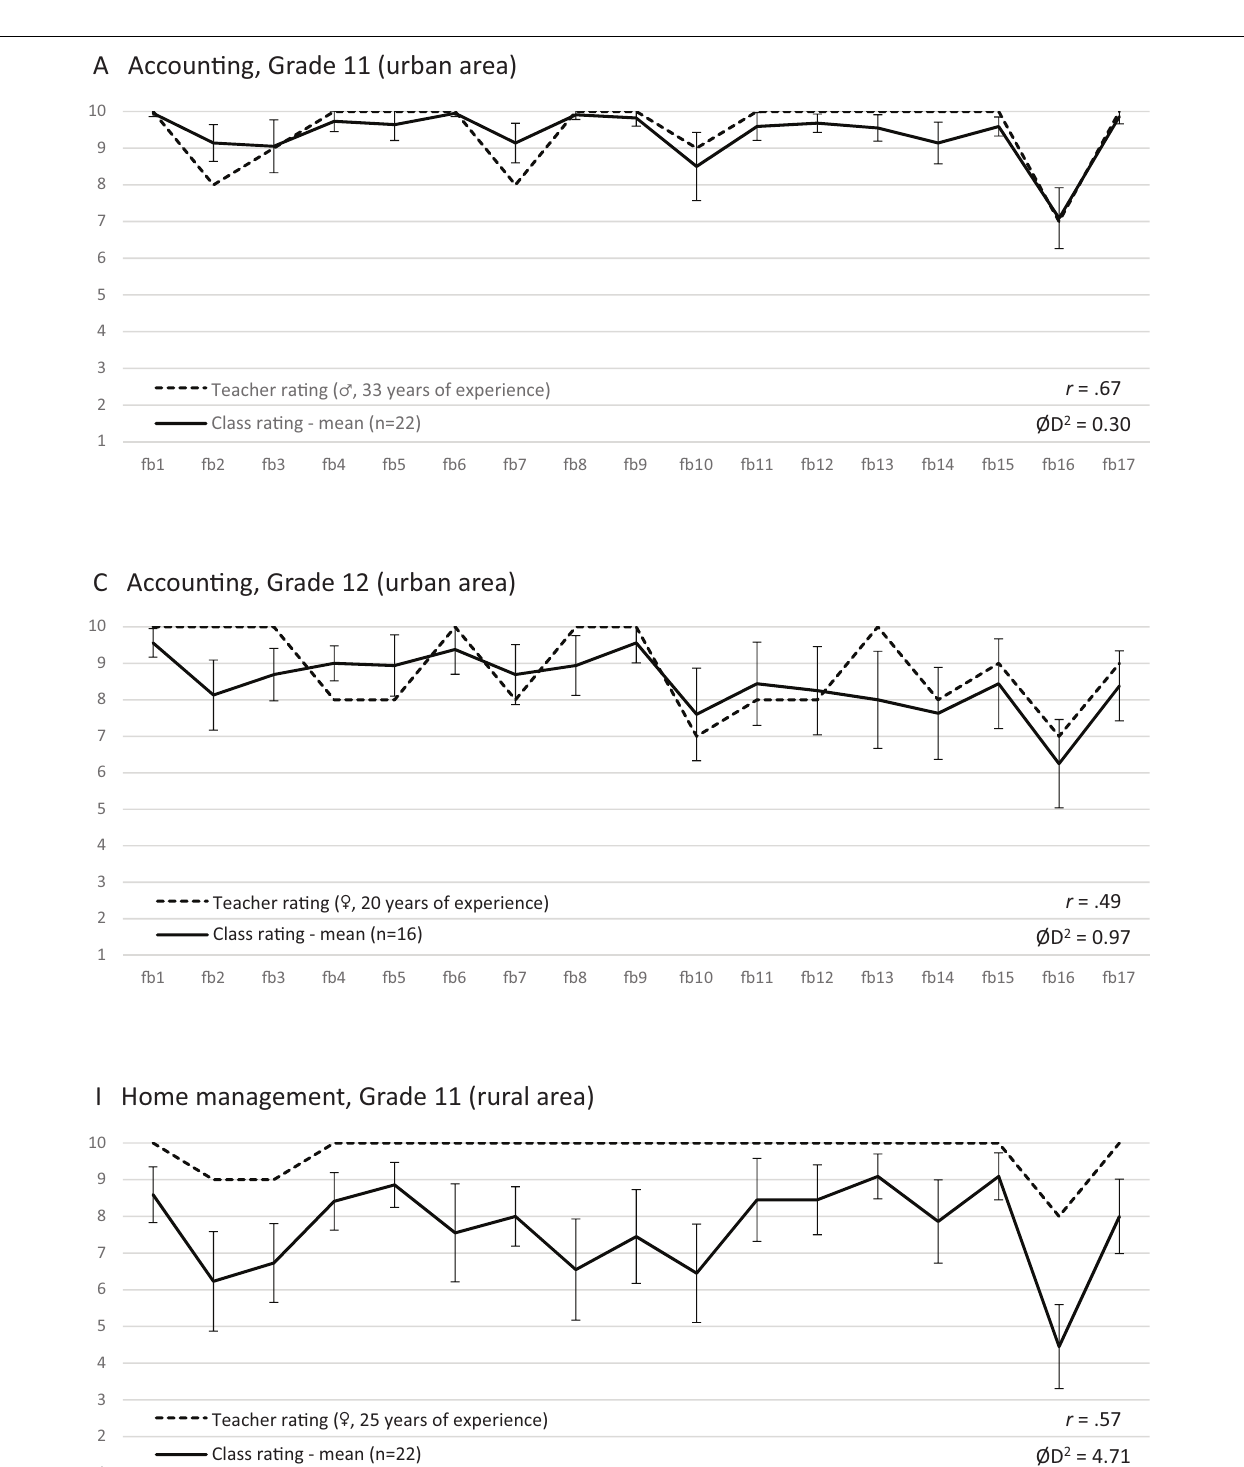
Frontiers in Education |